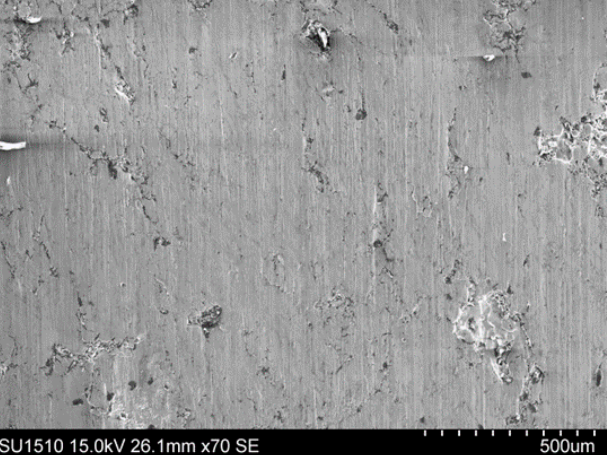
Figure 17. An electron microscopic image of the top view of sample A1 , after burnishing.